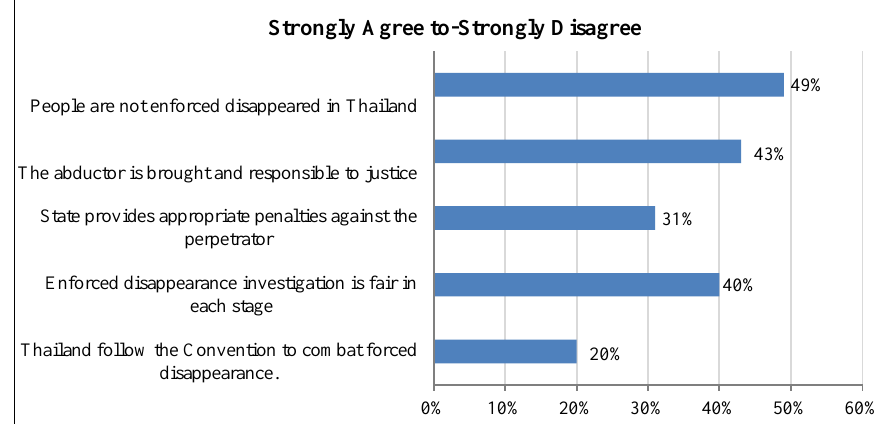
Figure 4. Limited level of compliance with the provisions of a fair investigation, penalty, and abductor brought to justice, and to combat enforced disappearance